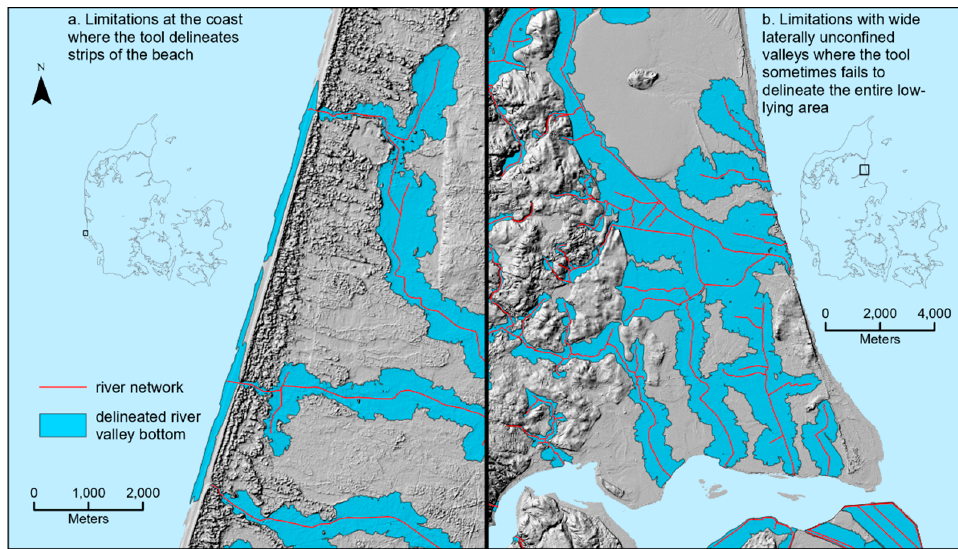
Figure 12. Limitations of our river valley bottom delineation tool showing ( a ) limitations at coastal areas in which the tool delineates strips of the beach and ( b ) limitations with wide laterally unconfined valleys where, in some cases, the tool fails to delineate the entire low-lying area delineating valleys from individual rivers only.